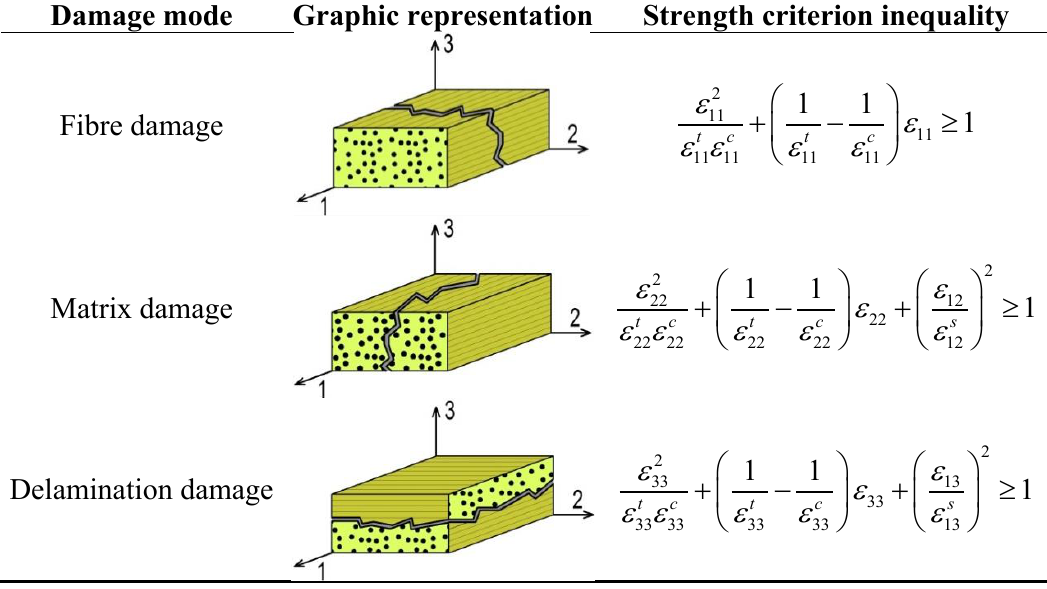
Table 1. Inequalities of the strength criterion according to different damage modes. Damage mode Graphic representation Strength criterion